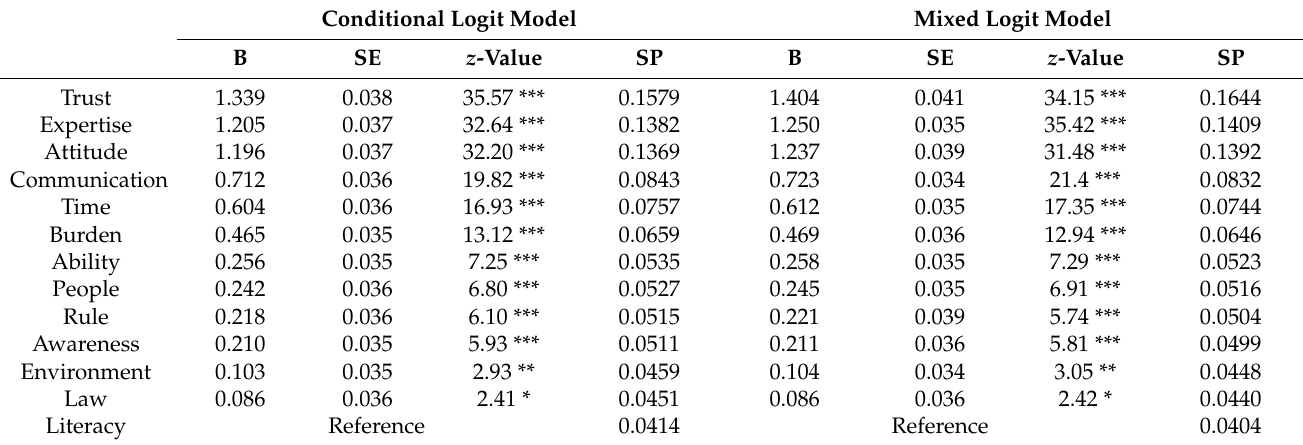
Table 5. Results of the conditional logit regression and mixed logit regression